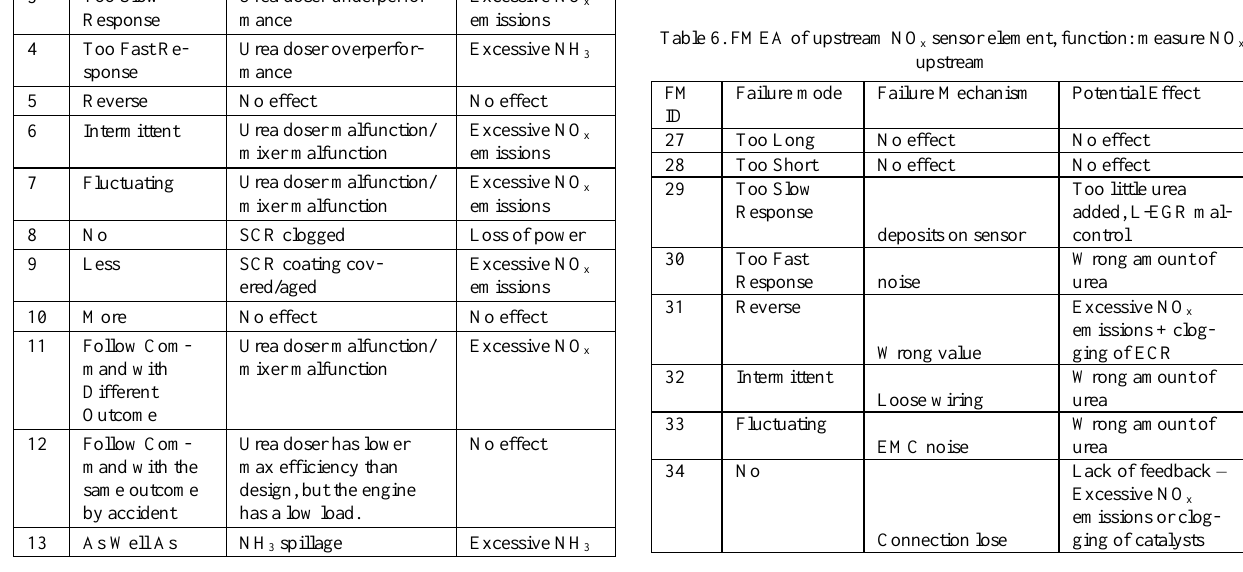
Table 6. FMEA of upstream NO x sensor element, function: measure NO x